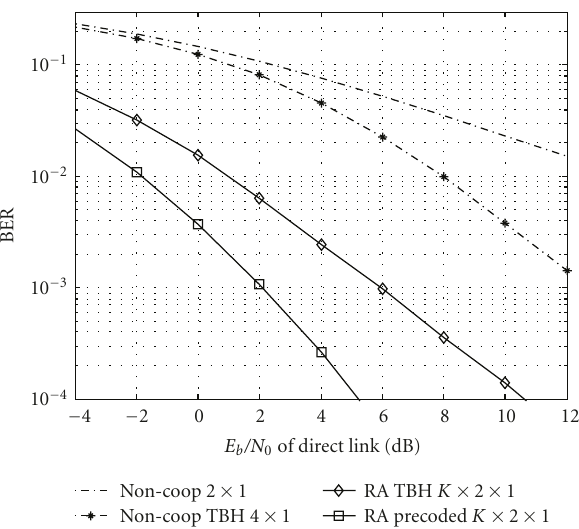
Figure 15: BER of cooperative systems with 2 antennas per relay and of reference systems for Scenario